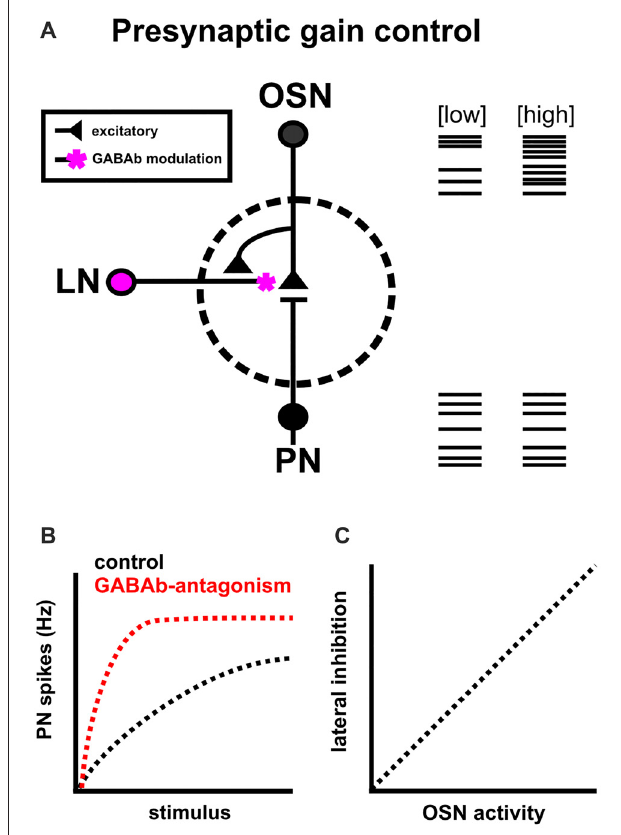
FIGURE 2 | Intrinsic modulation as a means of presynaptic gain control. (A) Presynaptic gain control alters the signal strength between OSNs and PNs to filter out noise from spontaneous firing of OSNs, avoid PN saturation and expand the dynamic range of PNs. It does this by reducing presynaptic calcium levels in OSNs via GABAb receptors, and reducing the likelihood of acetycholine release onto PNs. (B) GABAb blockade (red) increases presynaptic calcium influx and decreases the range of OSN input over which PN firing rate can change, ultimately resulting in PN saturation (based on results from Root et al., 2008; Olsen et al., 2010). (C) GABAergic lateral inhibition scales with network activation (as measured by OSN activity; Olsen and Wilson,